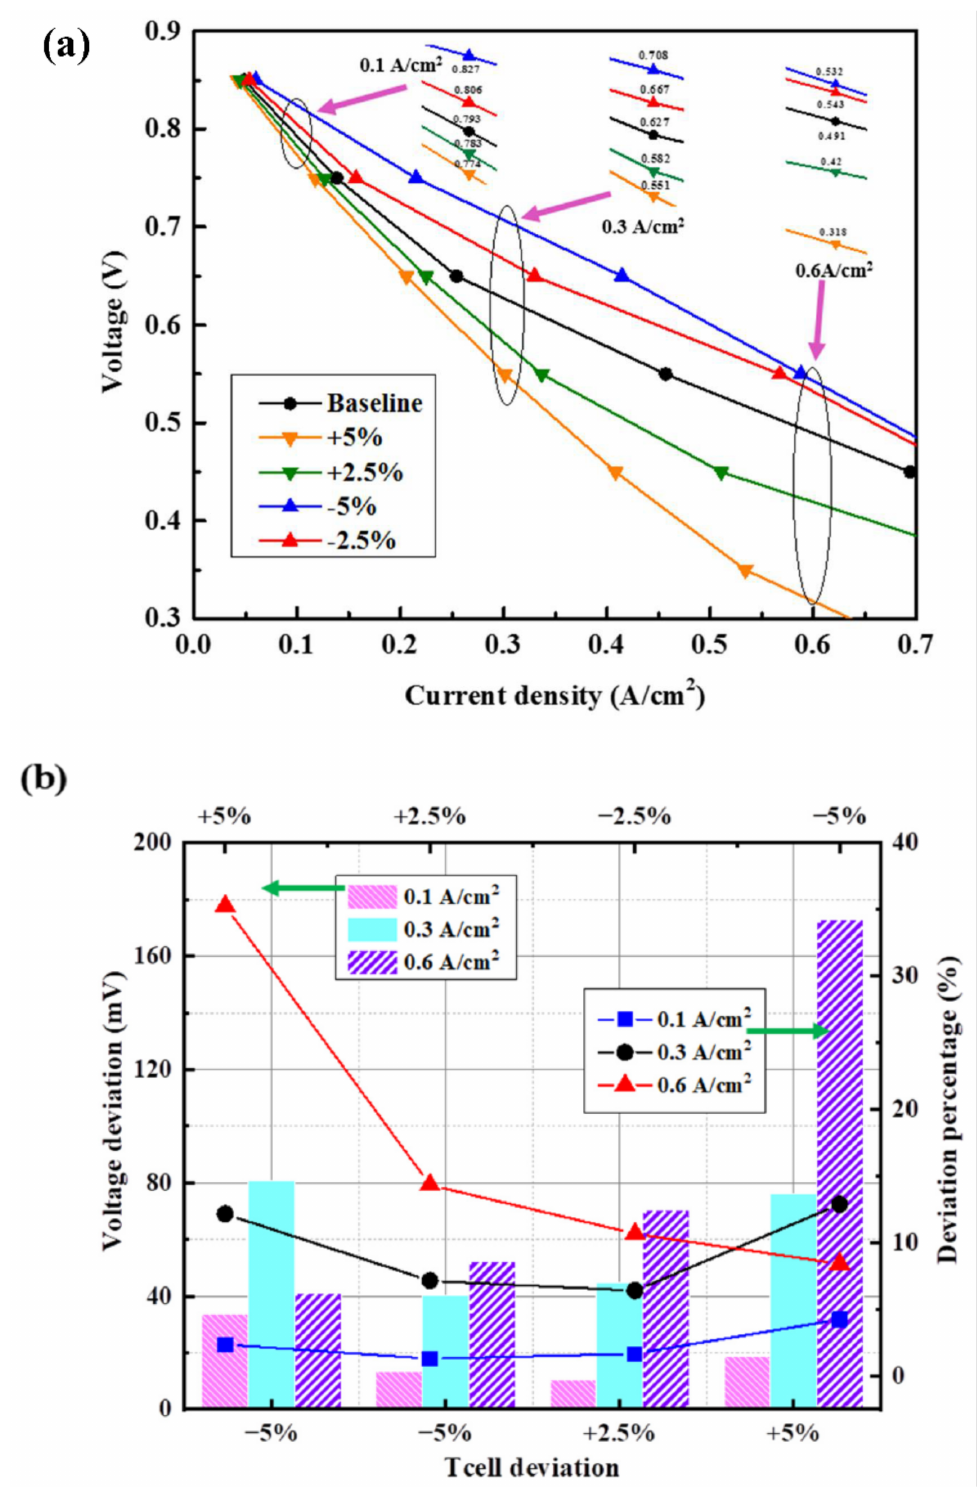
Figure 3. Impact of COT deviation on voltage: ( a ) polarization curves of different cell temperature, ( b ) the voltage deviation obtained by COT deviations and their corresponding percentages under three current densities. −